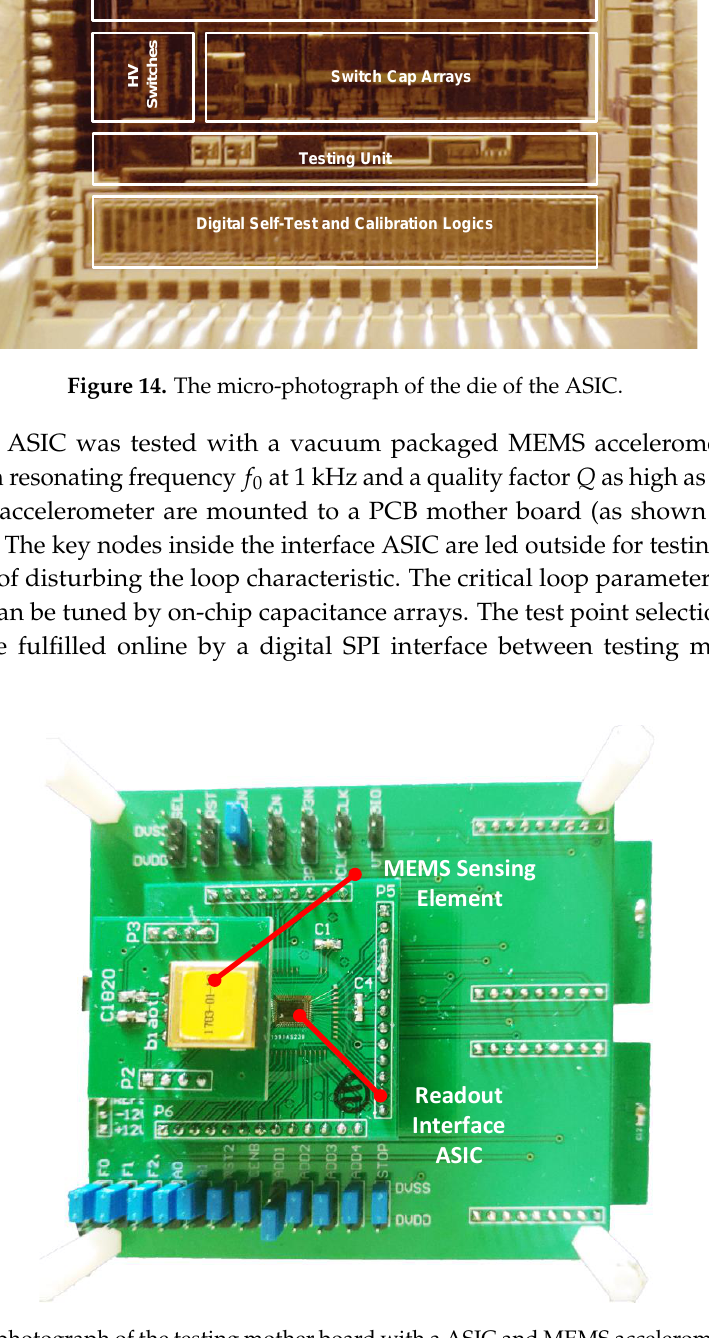
Figure 15. The photograph of the testing mother board with a ASIC and MEMS accelerometer